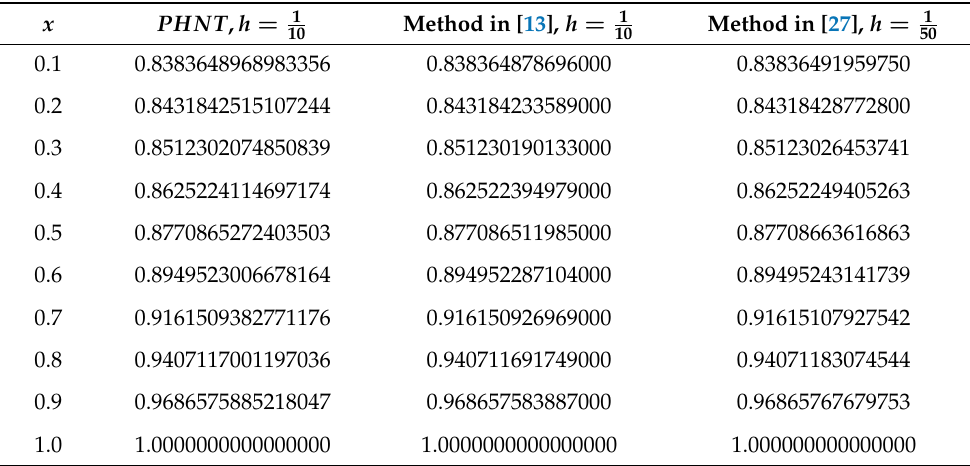
Table 3. Comparison of approximation solutions for test problem 4 for λ =